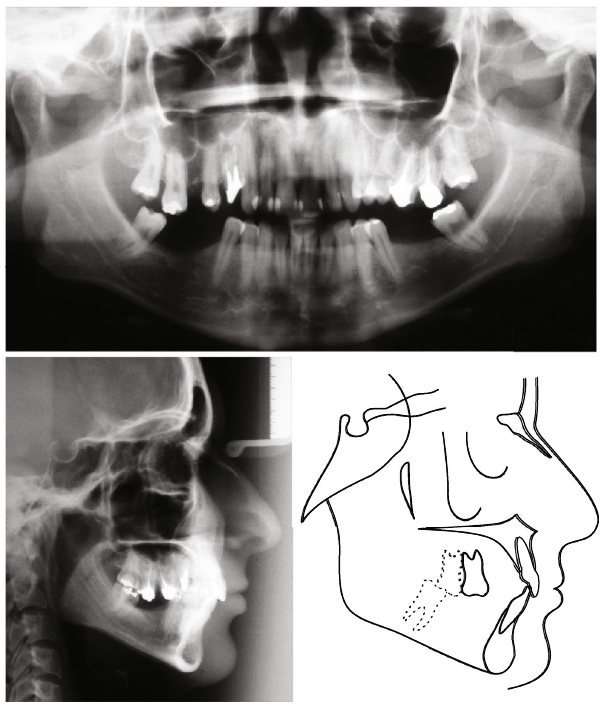
Figure 3: Pretreatment panoramic radiograph, lateral cephalometric radiograph, and tracing. Table 1: Cephalometric